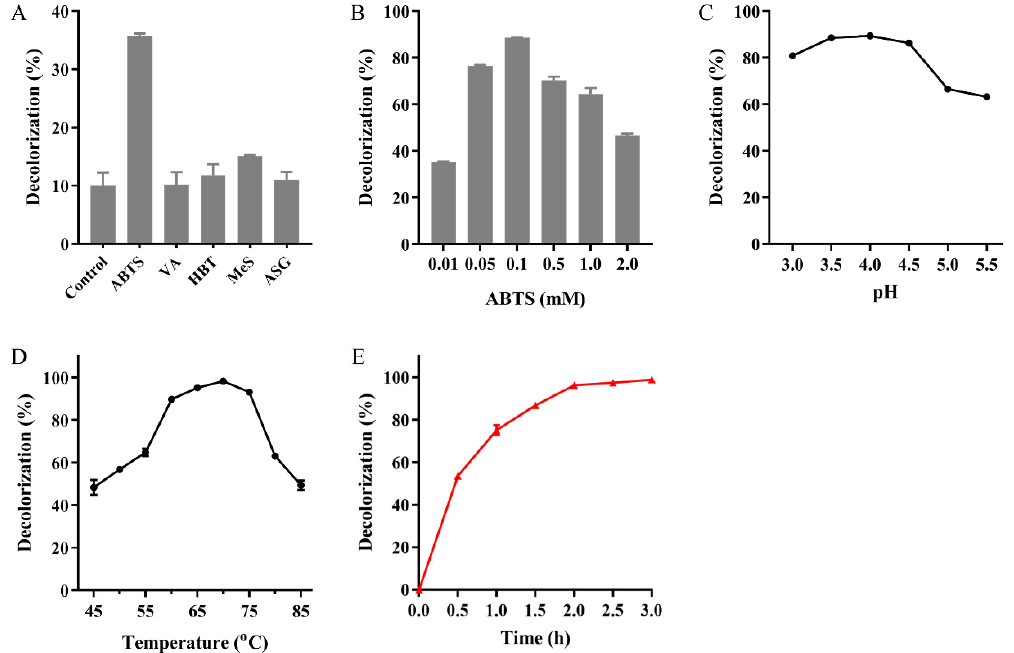
Figure 6. MG decolorization catalyzed by Mut2. The effects of different mediators ( A ) and ABTS concentration ( B ) on MG decolorization. VA, HBT, MeS, and ASG were the abbreviations of violuric acid, 1-hydroxybenzotriazole, Methyl syringate, and acetosyringone, respectively. The optimal pH ( C ) and temperature ( D ) of MG decolorization. ( E ) The time course of MG decolorization.